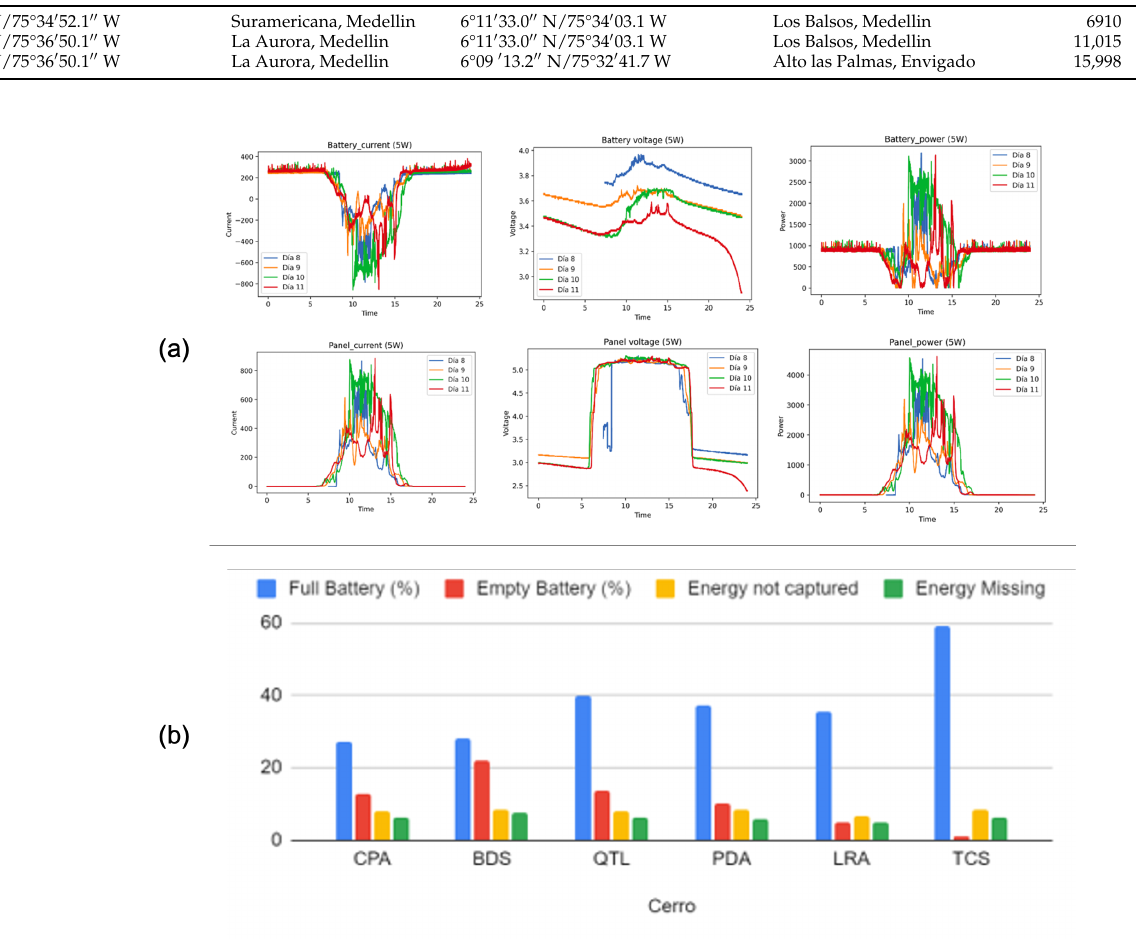
Figure 8. ( a ) Current, Voltage, and Power (Watts) before the battery and before the load measure for four days, ( b ) Energy supply simulation for the percentage of full, empty, not captured, and missing energy at the different point locations in the mountains around